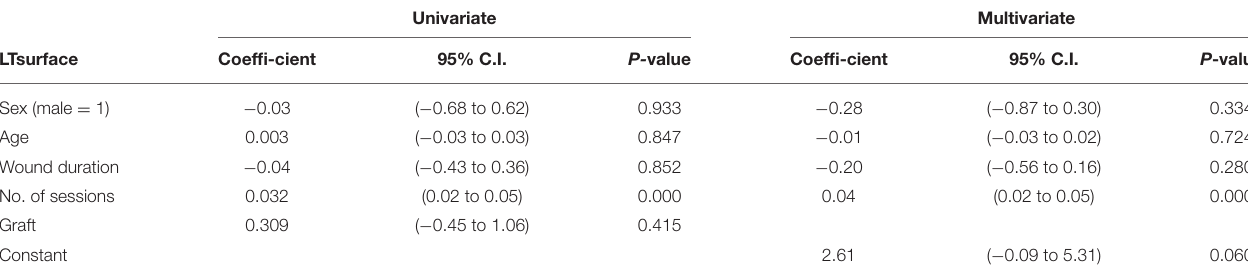
TABLE 3 | Association of decrease in wound surface area with explanatory variables. Univariate Multivariate LTsurface